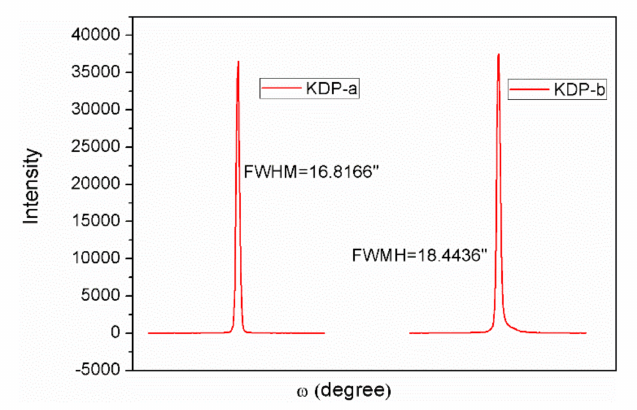
Figure 11. Rocking curves recorded for (001) faces of [101] direction KDP crystals.